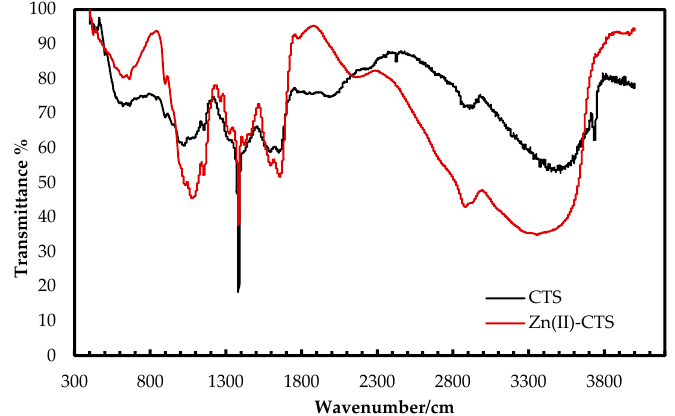
Figure 1. Fourier transform infrared (FT-IR) spectra of CTS and Zn(II)–CTS.